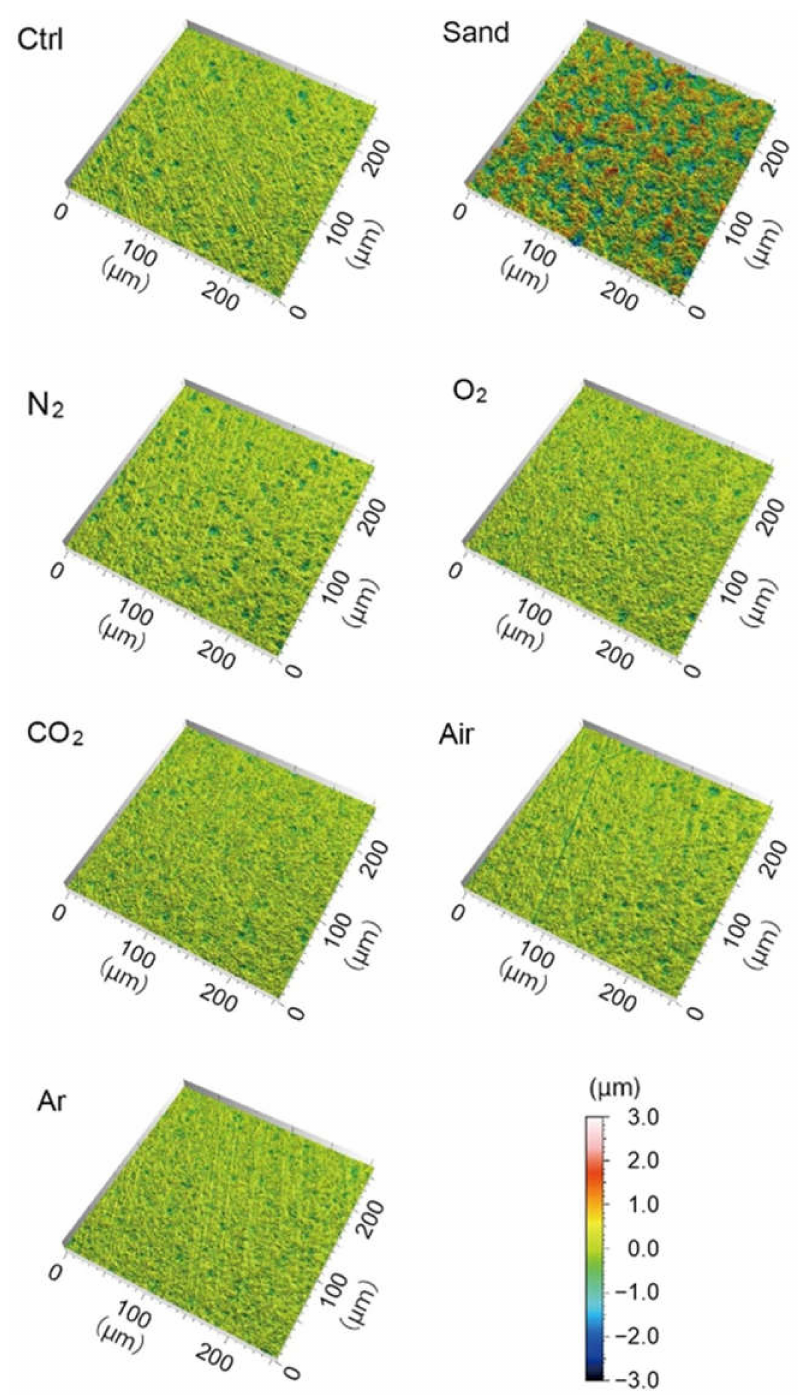
Figure 4. Representative images of zirconia surface after sandblasting or plasma irradiation using different gas